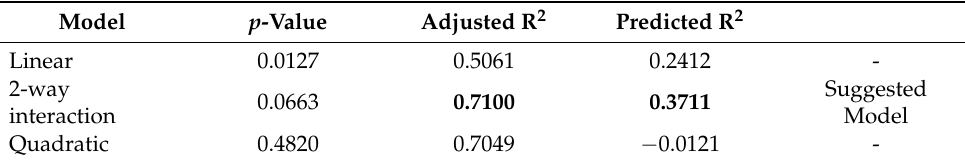
Table 4. Mathematical model analysis.